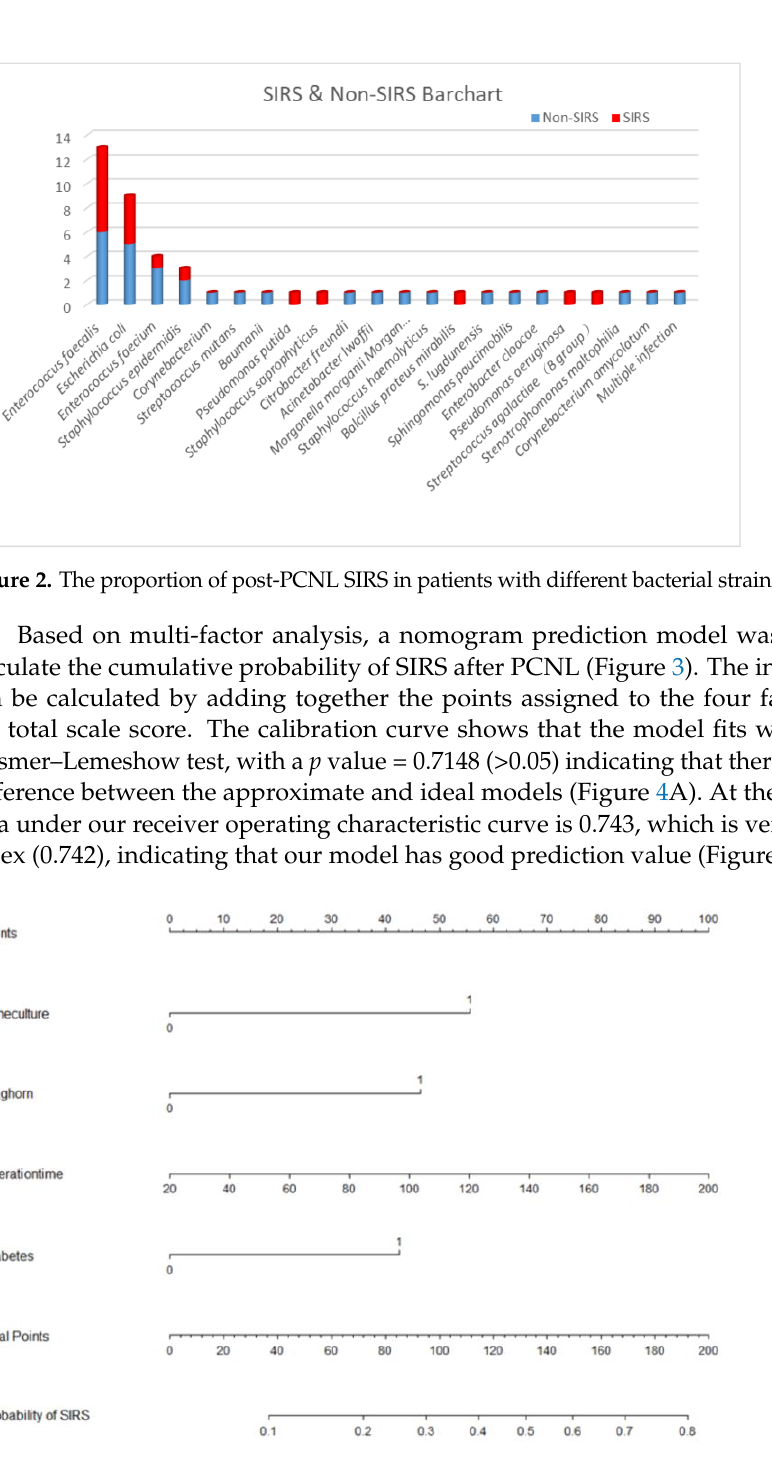
Figure 1. The genera and proportions of bacterial strains from patients with positive urine cul- tures.